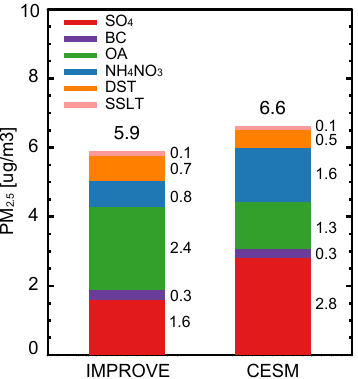
Figure 3. Simulated and observed PM 2 . 5 chemical species over the United States. Big numerals indicate the annual PM 2 . 5 concentra- tions, whereas small numerals indicate PM 2 . 5 chemical species con- centrations.